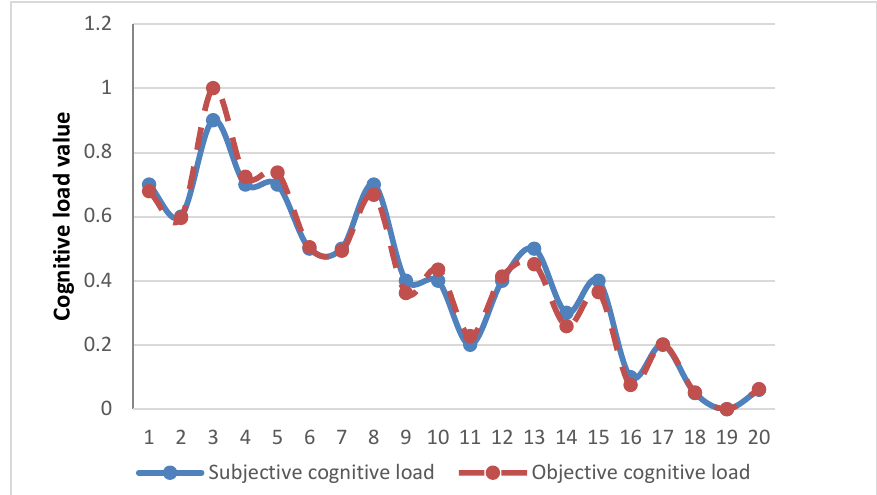
Figure 4. The cognitive load evaluated by the probabilistic neural network model is compared with the actual cognitive load.